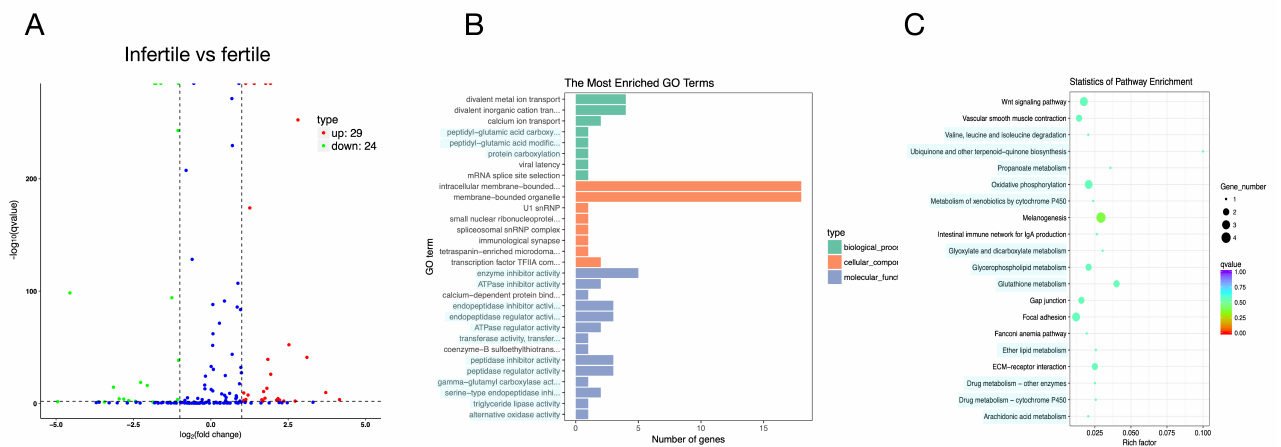
Figure 5. Volcano plot, GO/pathway analysis for target genes of DE miRNAs between infertile and fertile group in Paralichthys olivaceus . ( A ) Volcano plot for target genes of DE miRNAs. The red spots, green spots, and blue spots separately represent up-regulated, down-regulated, and undifferentiated target genes of DE miRNAs. ( B ) Histogram of Gene Ontology (GO) enrichment for target genes of DE miRNAs. ( C ) Top 20 changed pathways for target genes of DE miRNAs.